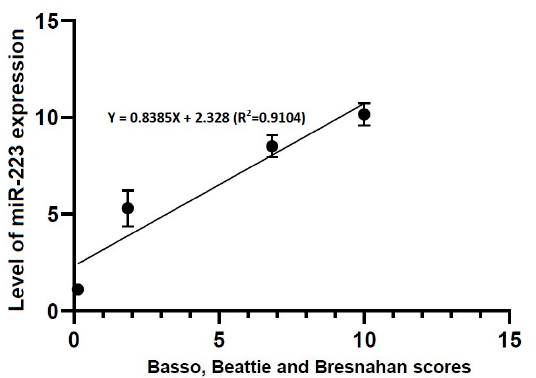
Figure 6. Correlation between locomotor rating scale scores and the level of miR-21 expression. The locomotor rating scale scores had a linear relationship with the level of miR-21 expression (R 2 = 0.4363, Y = 1.661X + 3.096).